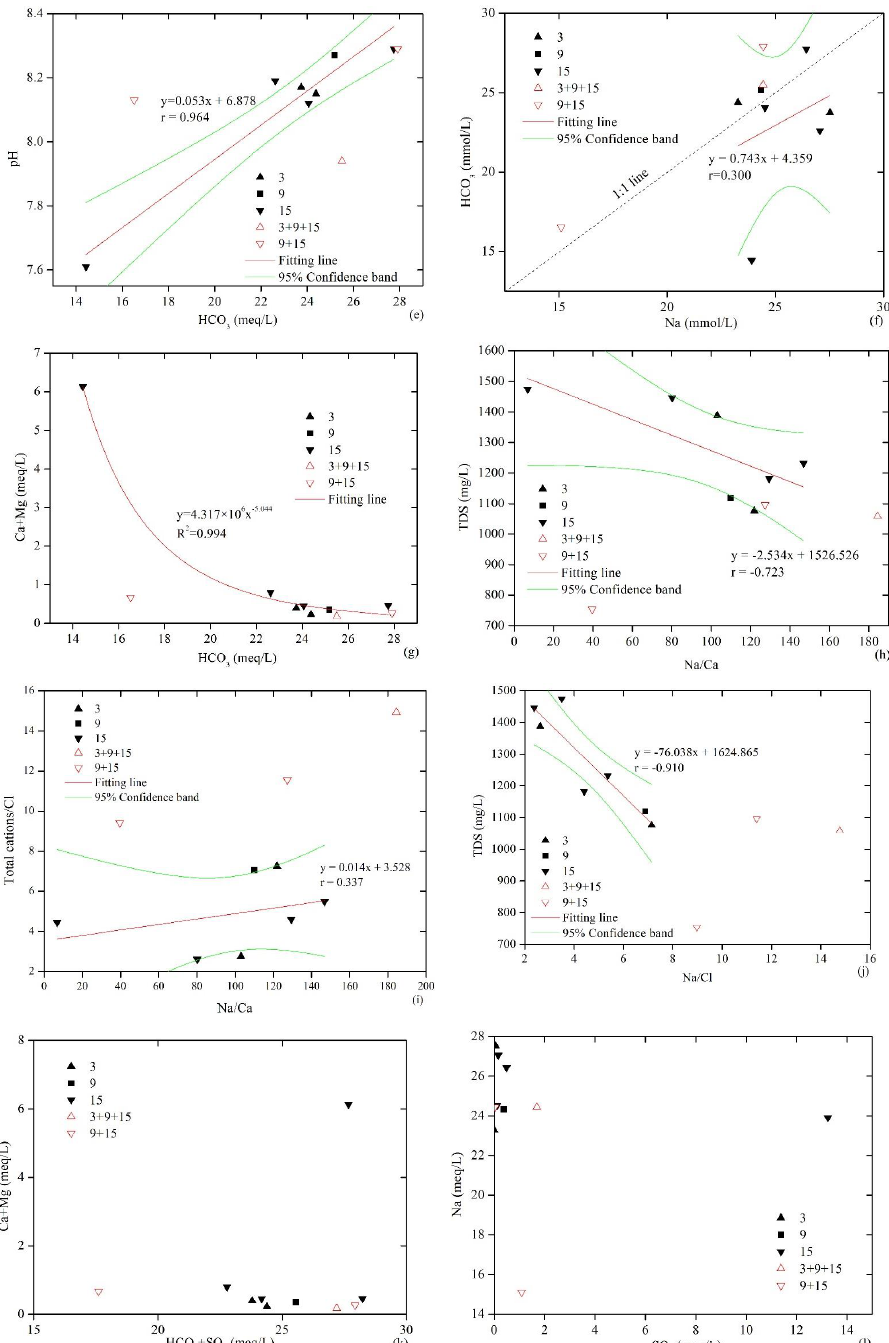
Figure 3. Relationships between the ionic compositions of produced water samples. ( a ) Na versus Cl; ( b ) Na − Cl versus (Ca + Mg) − (HCO 3 + SO 4 ); ( c ) SO 4 versus HCO 3 ; ( d ) SO 4 versus pH; ( e ) HCO 3 versus pH; ( f ) Na versus HCO 3 ; ( g ) HCO 3 versus Ca + Mg; ( h ) Na/Ca versus TDS; ( i ) Na/Ca versus Total cations/Cl; ( j ) Na/Cl versus TDS; ( k ) HCO 3 + SO 4 versus Ca + Mg; ( l ) SO 4 versus Na.